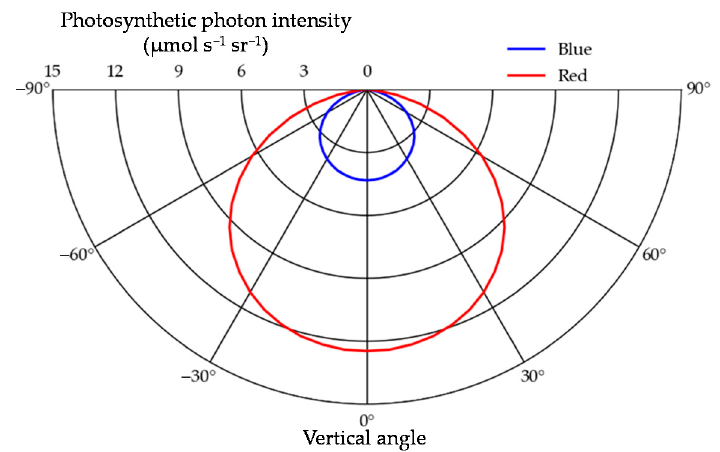
Figure 6. The photometric curves of the BRLED lamp. The values of the photosynthetic photon intensity of the blue and red light were written in IES files for the BRLED lamp, respectively. These half-value angles are approximately 60°.